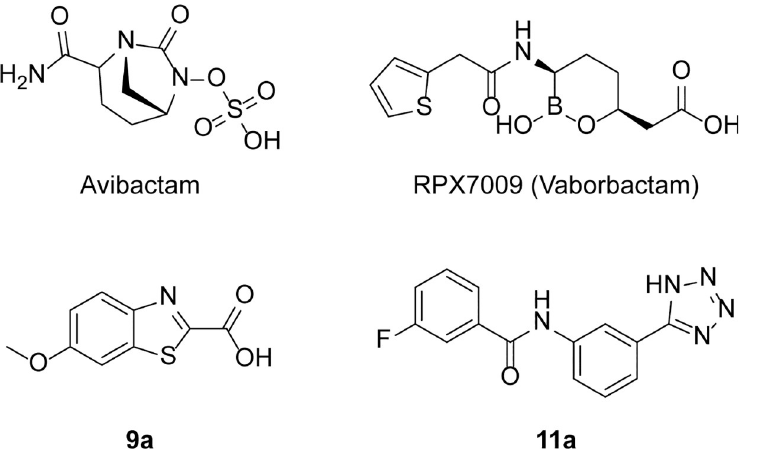
Fig 1. Chemical structure of avibactam, RPX7009, and compounds 9a and 11a.